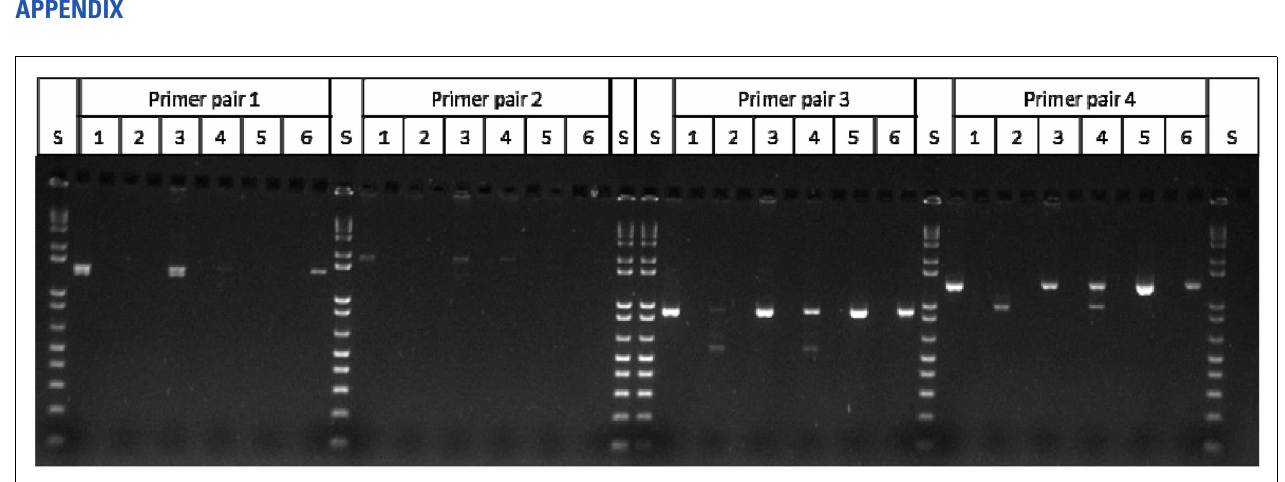
size = 1400bp); Primer Pair 2: amy4-flank + mudrA-1298r (expected size = 1819bp); Primer Pair 3: amy4-muk_512f + mudrA-899r a chimeric primer that is expected to amplify both Mu killer and MuDR